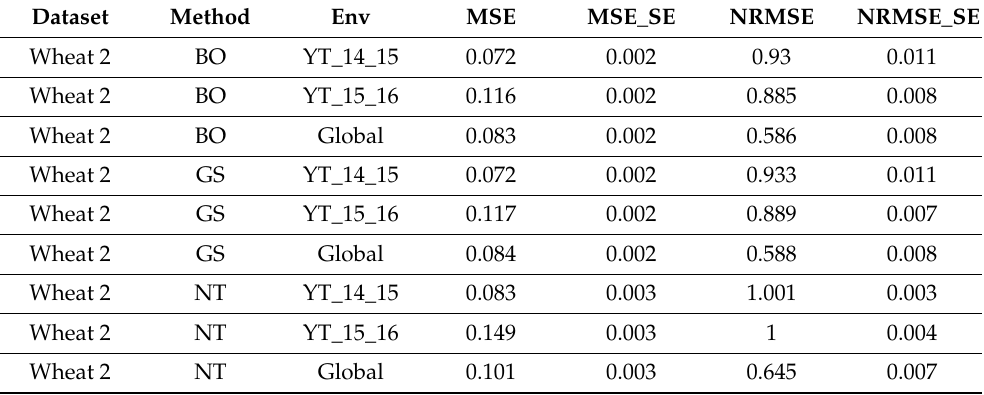
Table A3. Prediction performance for every environment and across environments (Global) of dataset 2 in terms of mean squared error (MSE), normalized root mean Square Error (NRMSE) under three methods of tuning (BO, GrS, and NT). MSE_SE and NRMSE_SE denotes the standard errors (SE) under MSE and